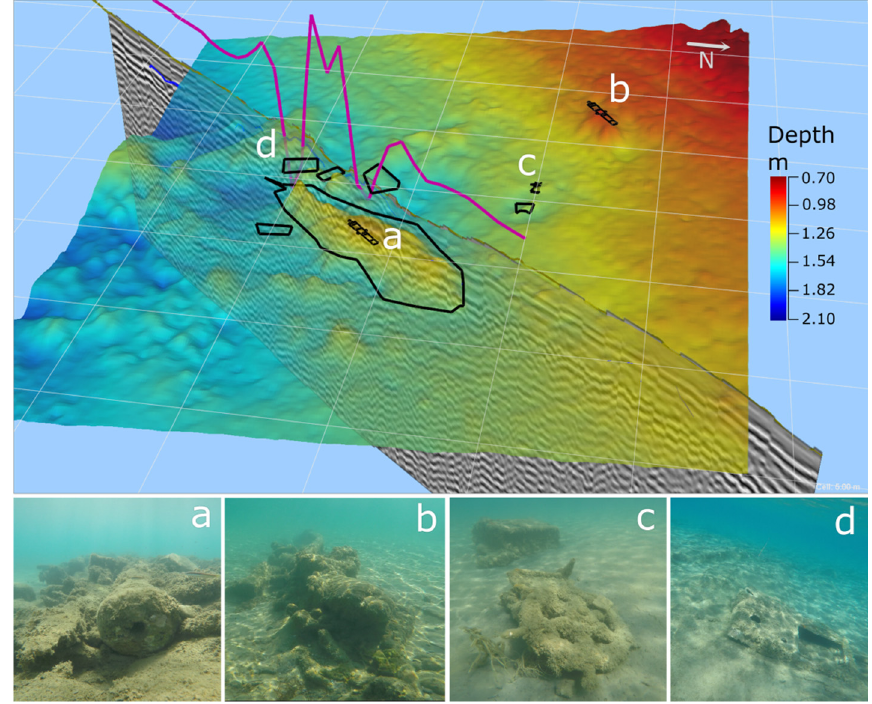
Figure 7. A 3D synthesis of marine geophysical data for ‘wreck site 1’ visualisation and analysis. Site bathymetry is shown semi-transparent and demonstrates the wreck mound and the sediment heaps west and south of the wreck. Drawings (in black) display the wreck mound periphery, a cannon ( a ) over the mound, another cannon ( b ) over a gunwale-like section, a ship’s wheel ( c ), and scattered wreck-related ruins over the seafloor. The purple line illustrates a 30 nT magnetic anomaly over a sediment heap ( d ), along a boat transect. The seismic section along the transect is annotated (in blue) for reflectors interpreted as wreck-related buried material. Grid cell size (in white): 5 m × 5 m.